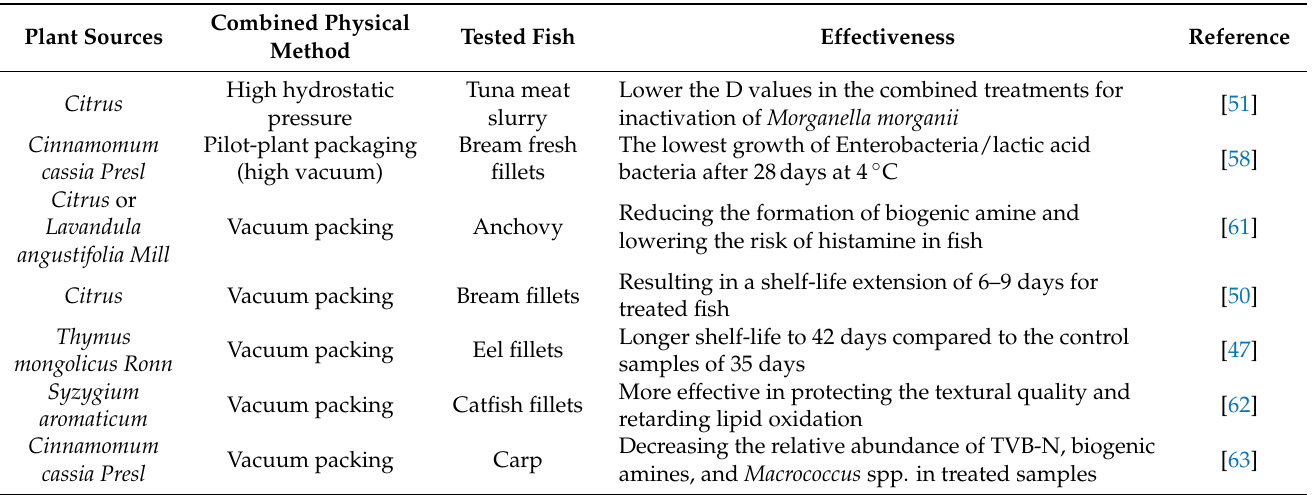
Table 3. Synergistic or additive effect of essential oils combined with physical methods on quality retention of seafood products. Plant